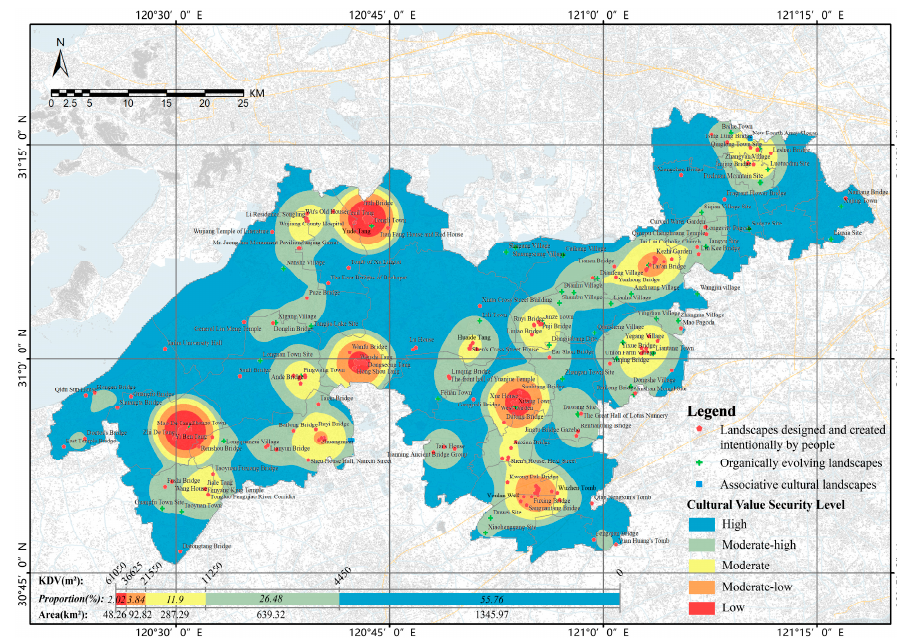
Figure 9. Cultural value security analysis of the demonstration area.